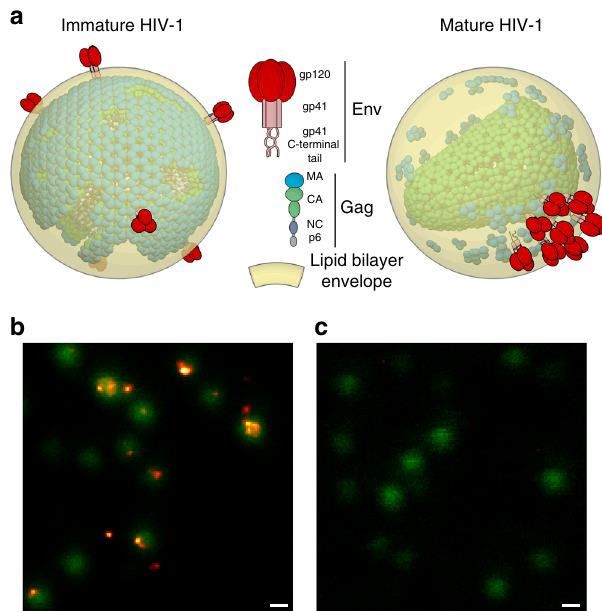
Fig. 1 Env organisation in live un fi xed HIV-1 particles. a Schematic illustration of Env and Gag distribution on mature and immature HIV-1. b , c Microscopy images of eGFP.Vpr ( green , confocal) and Env ( orange , STED) visualised by immunostaining in live un fi xed mature wild-type b and Env( − ) c HIV-1 particles, highlighting Env clustering and the Env-speci fi c labelling. Scale bar: 200